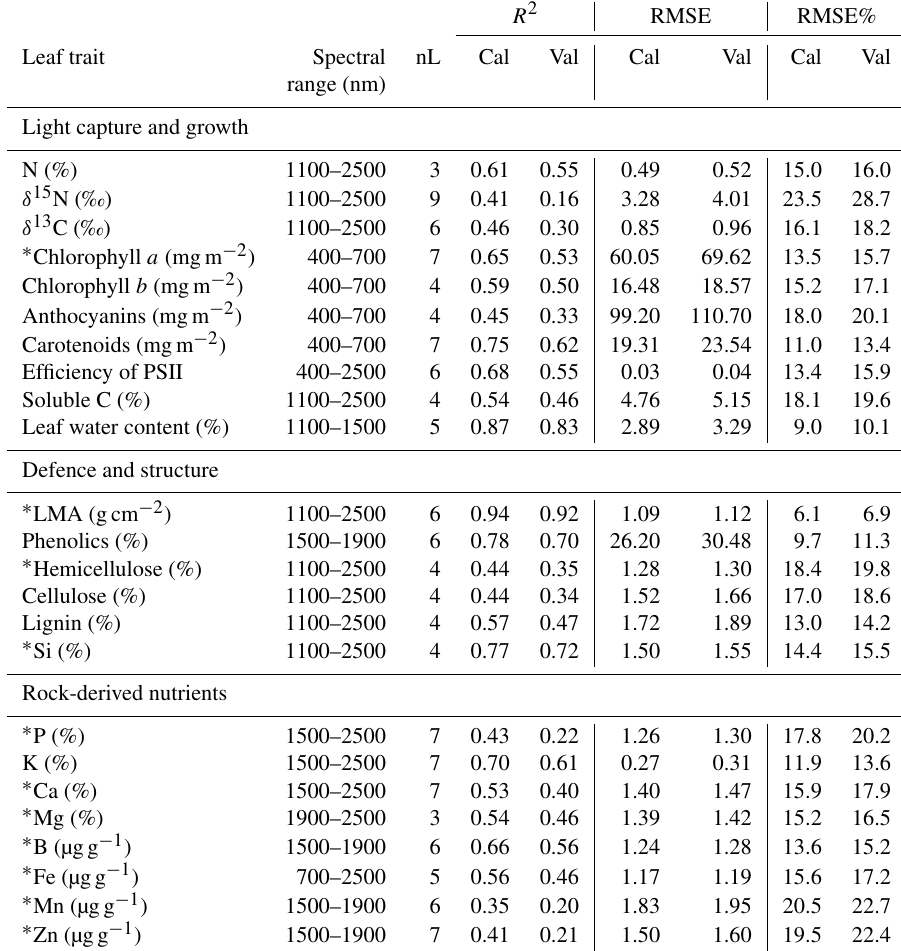
Table 2. Partial least squares regression (PLSR) on spectral data and leave-one-out cross-validation for 24 leaf traits of six species occurring on both alluvial and chalk soils. The model calibration (indicated with subscript cal) and validation (indicated as subscript val) performance was evaluated for each leaf trait by calculating the coefficient of determination ( R 2 ) , root mean square error (RMSE) and the percentage root mean square error (%) based on the given number of latent variables (nL) for each PLS